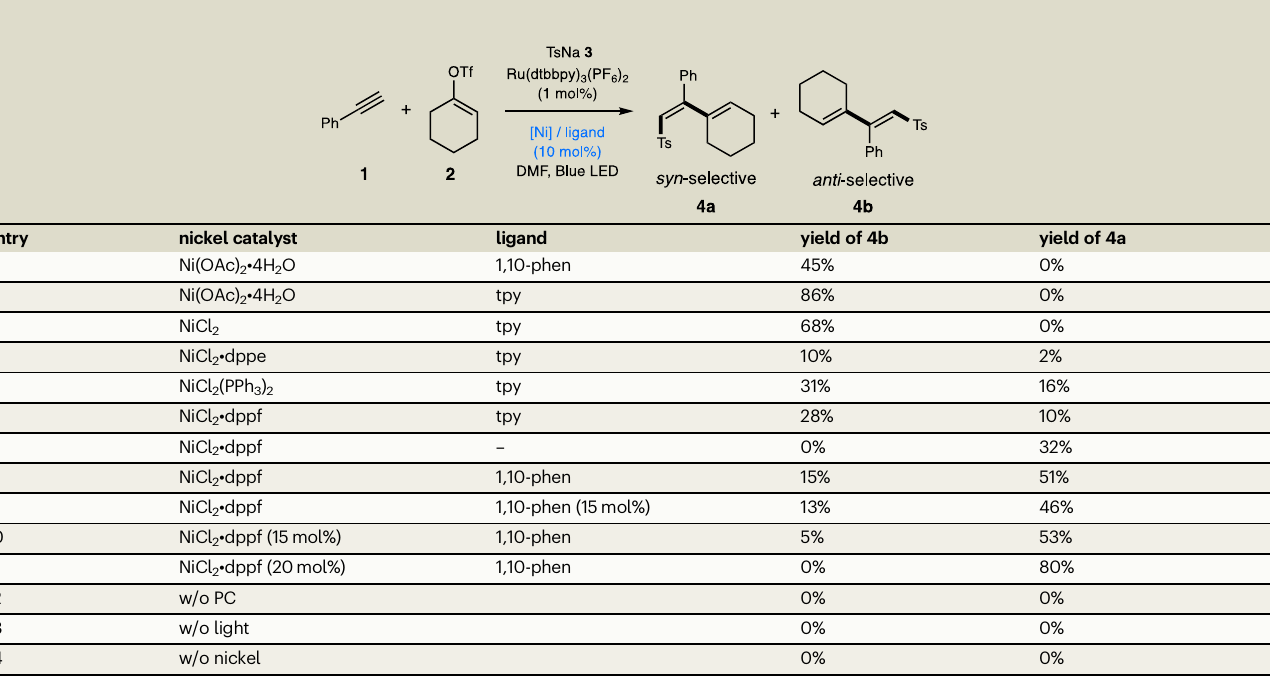
Table 1 | Optimization of reaction conditions